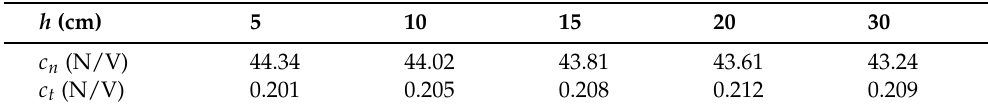
Table 1. Calibration coefficients of the sensor by experiment.